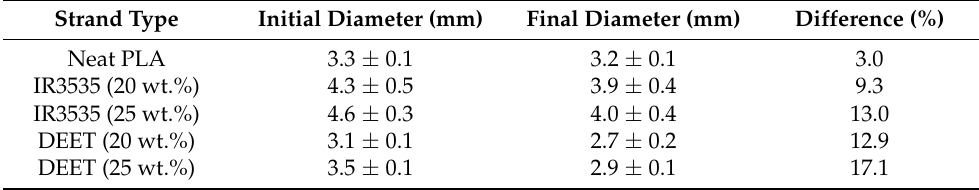
Table 2. Shrinkage of PLA-repellent strands expressed in wt.% evaluated at 50 ◦ C.